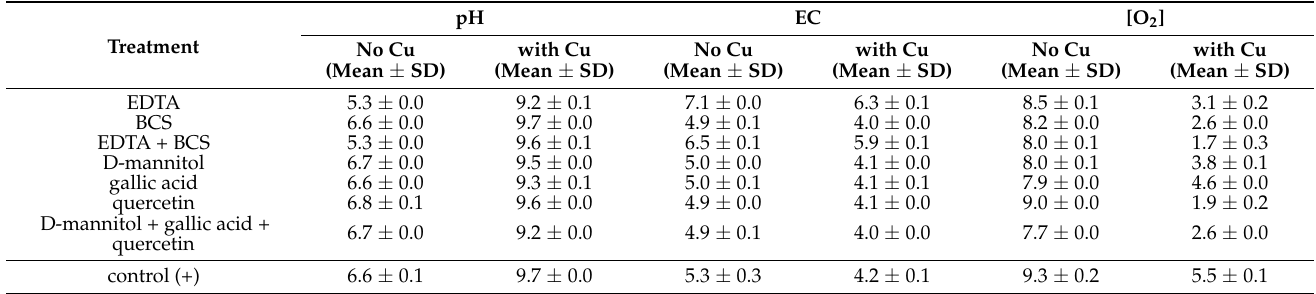
Table 1. Mean values for pH, electrical conductivity (EC) and the concentration of dissolved oxygen ([O 2 ]) for each treatment in milk artificially contaminated with MAP before (No Cu) and after (with Cu) being challenged with copper ions for 30 min.